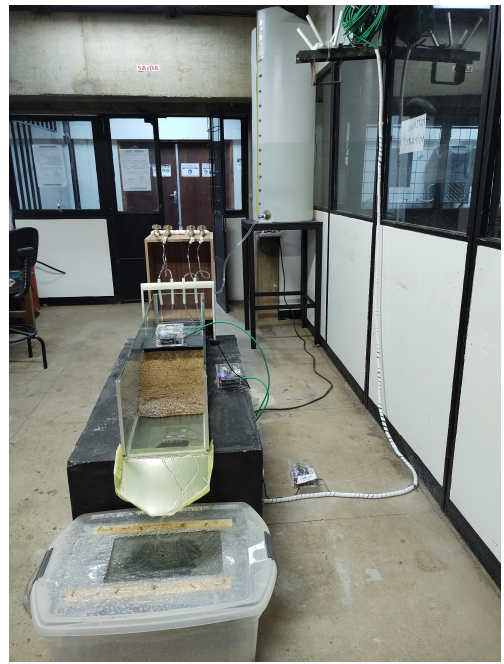
Figure 4. Frontal view of experimental